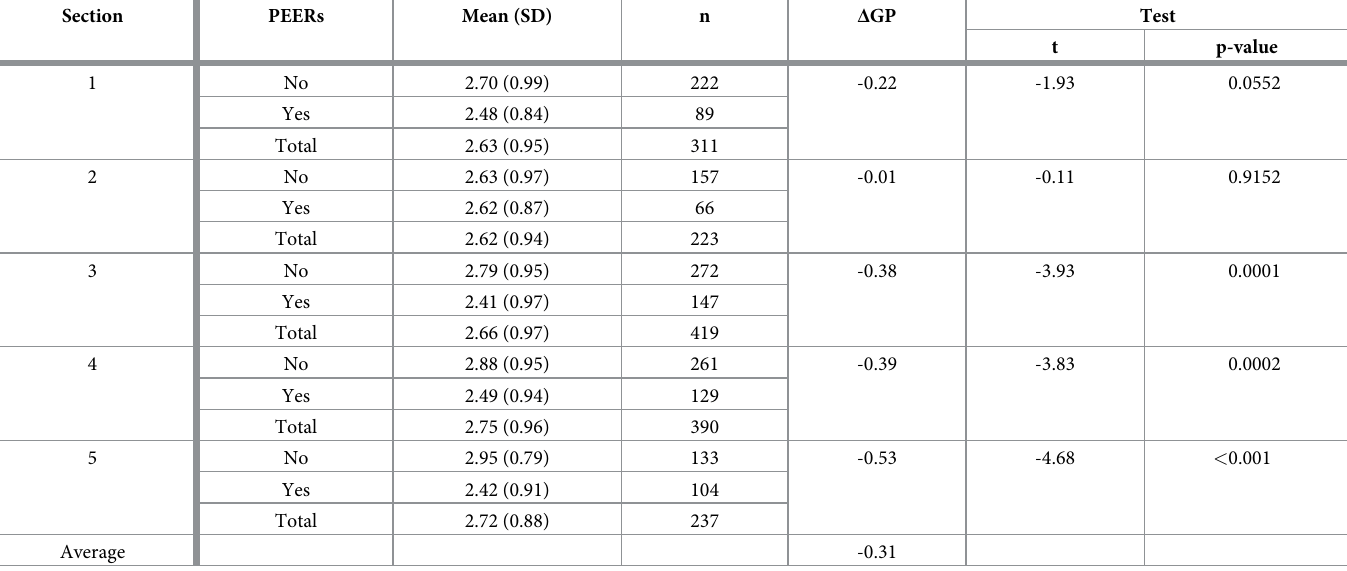
Table 2. Summary of the academic performance of PEERs and non-PEERs for Instructor J across 5 sections of the same course. Section